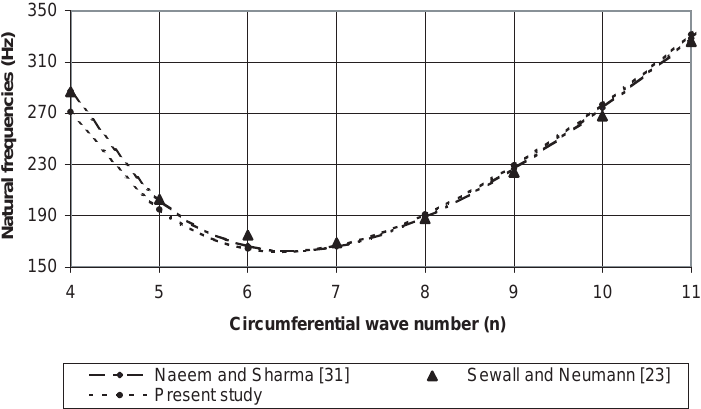
Fig. 3. Comparison of experimental and theoretical natural frequencies (Hz) of an isotropic cylindrical shell ( h 1 = 0 . 000648 (m), R = 0 . 2423 (m), L = 0 . 6096 (m), m = 1 , k 1 = 0 , ρ 0 = 2 . 7145 × 10 3 (kg/m 3 ), E 0 = 68 . 95 × 10 3 (MPa), ν = 0 . 315 ). sults obtained in this study and the experimental val- ues obtained in [37] are more approximate than the re- sults which are obtained in [3] by using finite elements